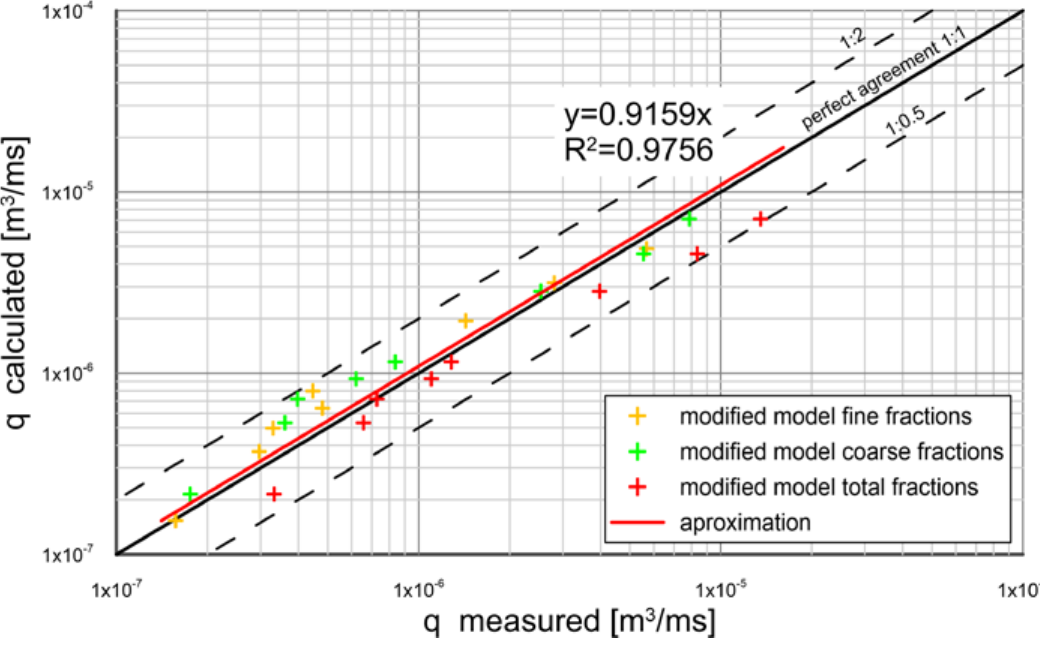
Figure 15. Transport calculations for Gda´nsk 2021 data, approximated by linear curve y = ax with a coefficient of determination R 2